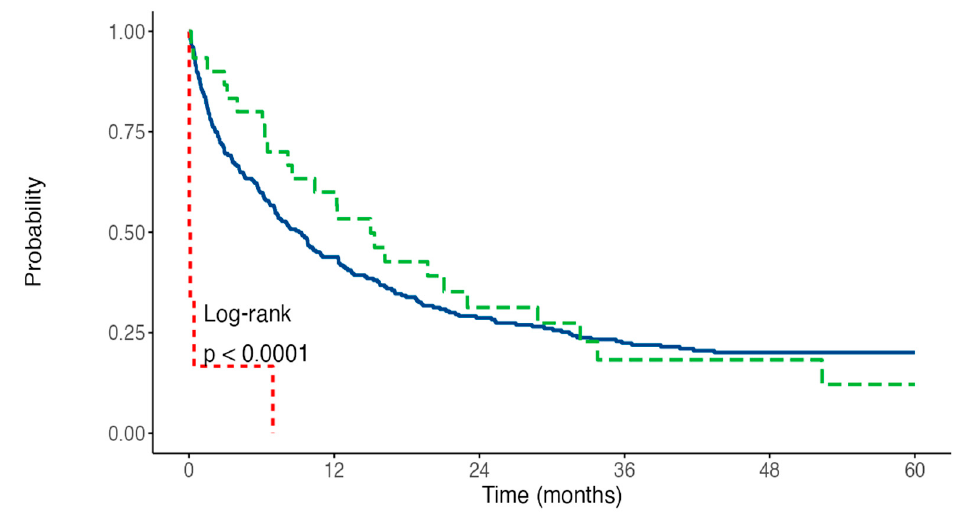
Figure 2. Overall Survival, patients with no TE in blue, VTE in green, ATE in red.